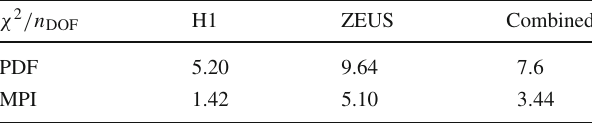
Table 2 χ 2 tests using three different